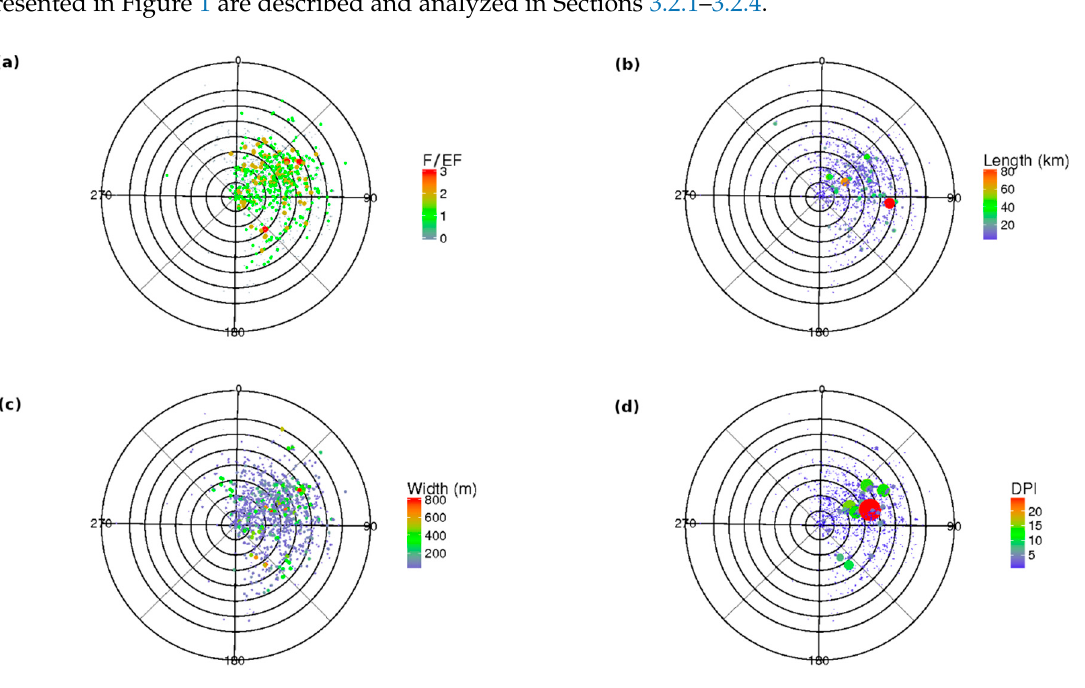
Figure 3. Spatial distribution of 1280 * tornadoes within the TC environment, stratified by F/EF scale ( a ), path length ( b ), path width ( c ), and DPI ( d ). Bearing in degrees is defined relative to north. Concentric range rings in km are place at an interval of 100 km. * Five tornadoes are not displayed because their ranges exceed 800 km.